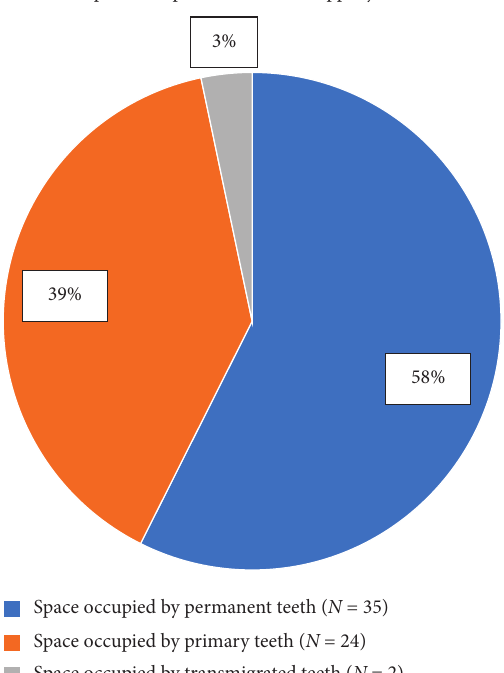
Figure 1: Distribution of spaces occupied by misplaced teeth in lower and upper jaws among study